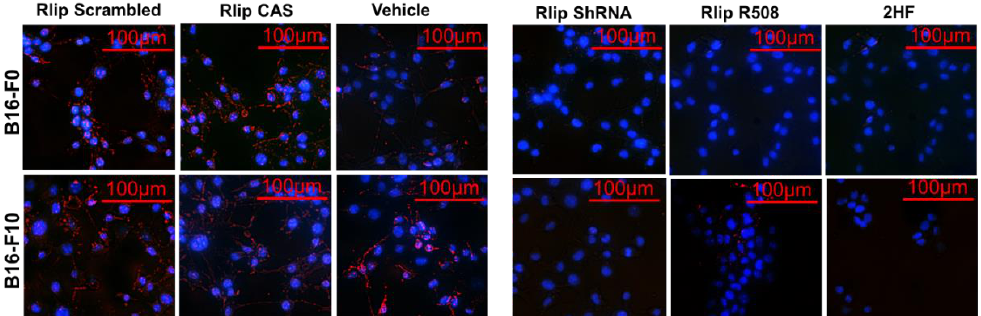
Figure 3. Effects of Rlip depletion on epidermal growth factor (EGF) endocytosis of mouse melanoma cells. Representative photomicrographs of Rlip-depleted B16-F0 and B16-F10 cells showing the inhibition of EGF-pHrodo endocytosis. EGF-pHrodo endocytosis is completely blocked in Rlip-depleted B16-F0 and B16-F10 cells. Rlip was depleted by treating cells with Rlip-antisense, Rlip-shRNA, or 10 µM 2HF for 24 h as described in Materials and Methods section 4.8. Photographs were taken at identical exposures using 200× magnification.